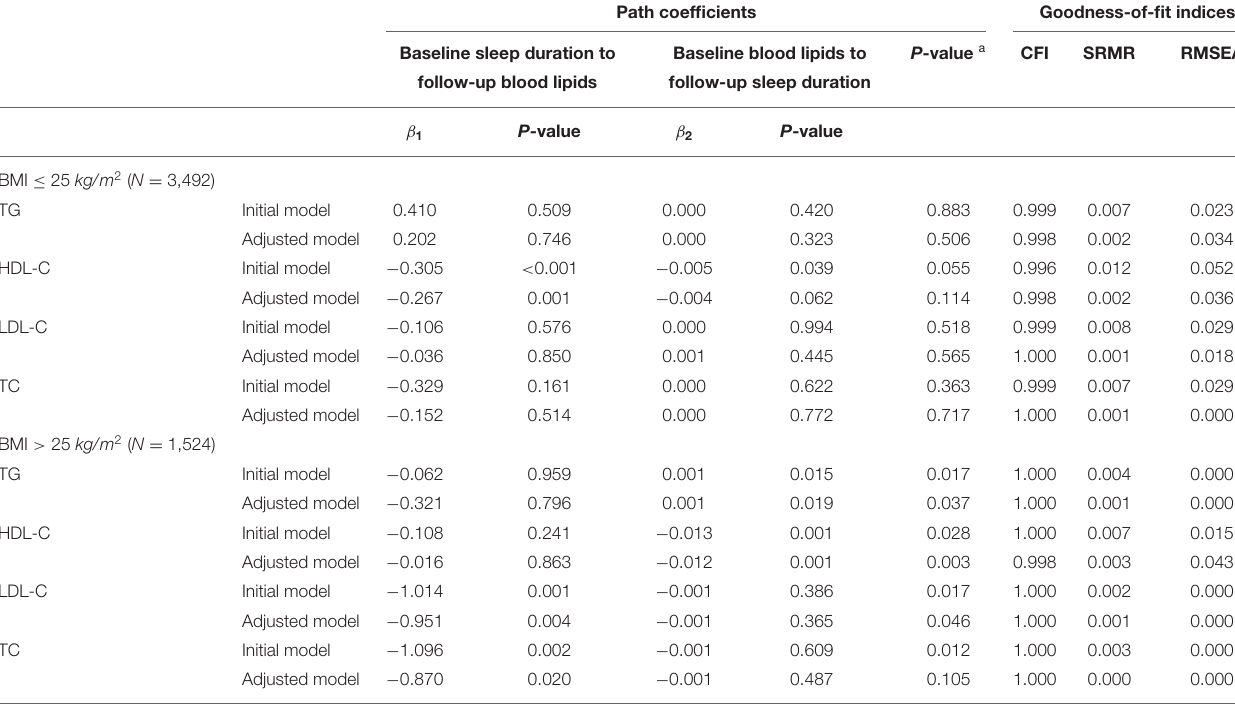
TABLE 4 | Cross-lagged path analysis of TG, HDL-C, LDL-C, TC and sleep duration by